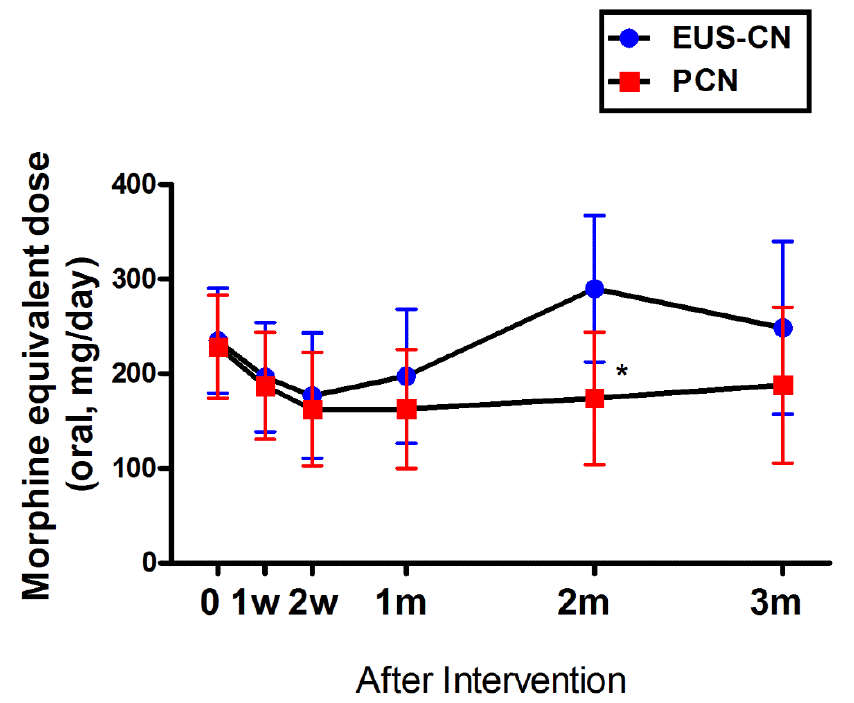
Figure 3. Changes in opioid consumption after EUS-CN or PCN. Opioid consumption was measured by calculating the daily opioid use converted to total daily oral morphine equivalent dose (MED). Adjusted prediction (95% CI) of opioid consumption in MED after intervention. A linear mixed model was used for the statistical analysis. Overall p -value between two groups for opioid consumption and difference from baseline was 0.22. CI, confidence interval; EUS-CN, endoscopic ultrasound-guided celiac neurolysis; PCN, percutaneous celiac neurolysis. * p < 0.05.